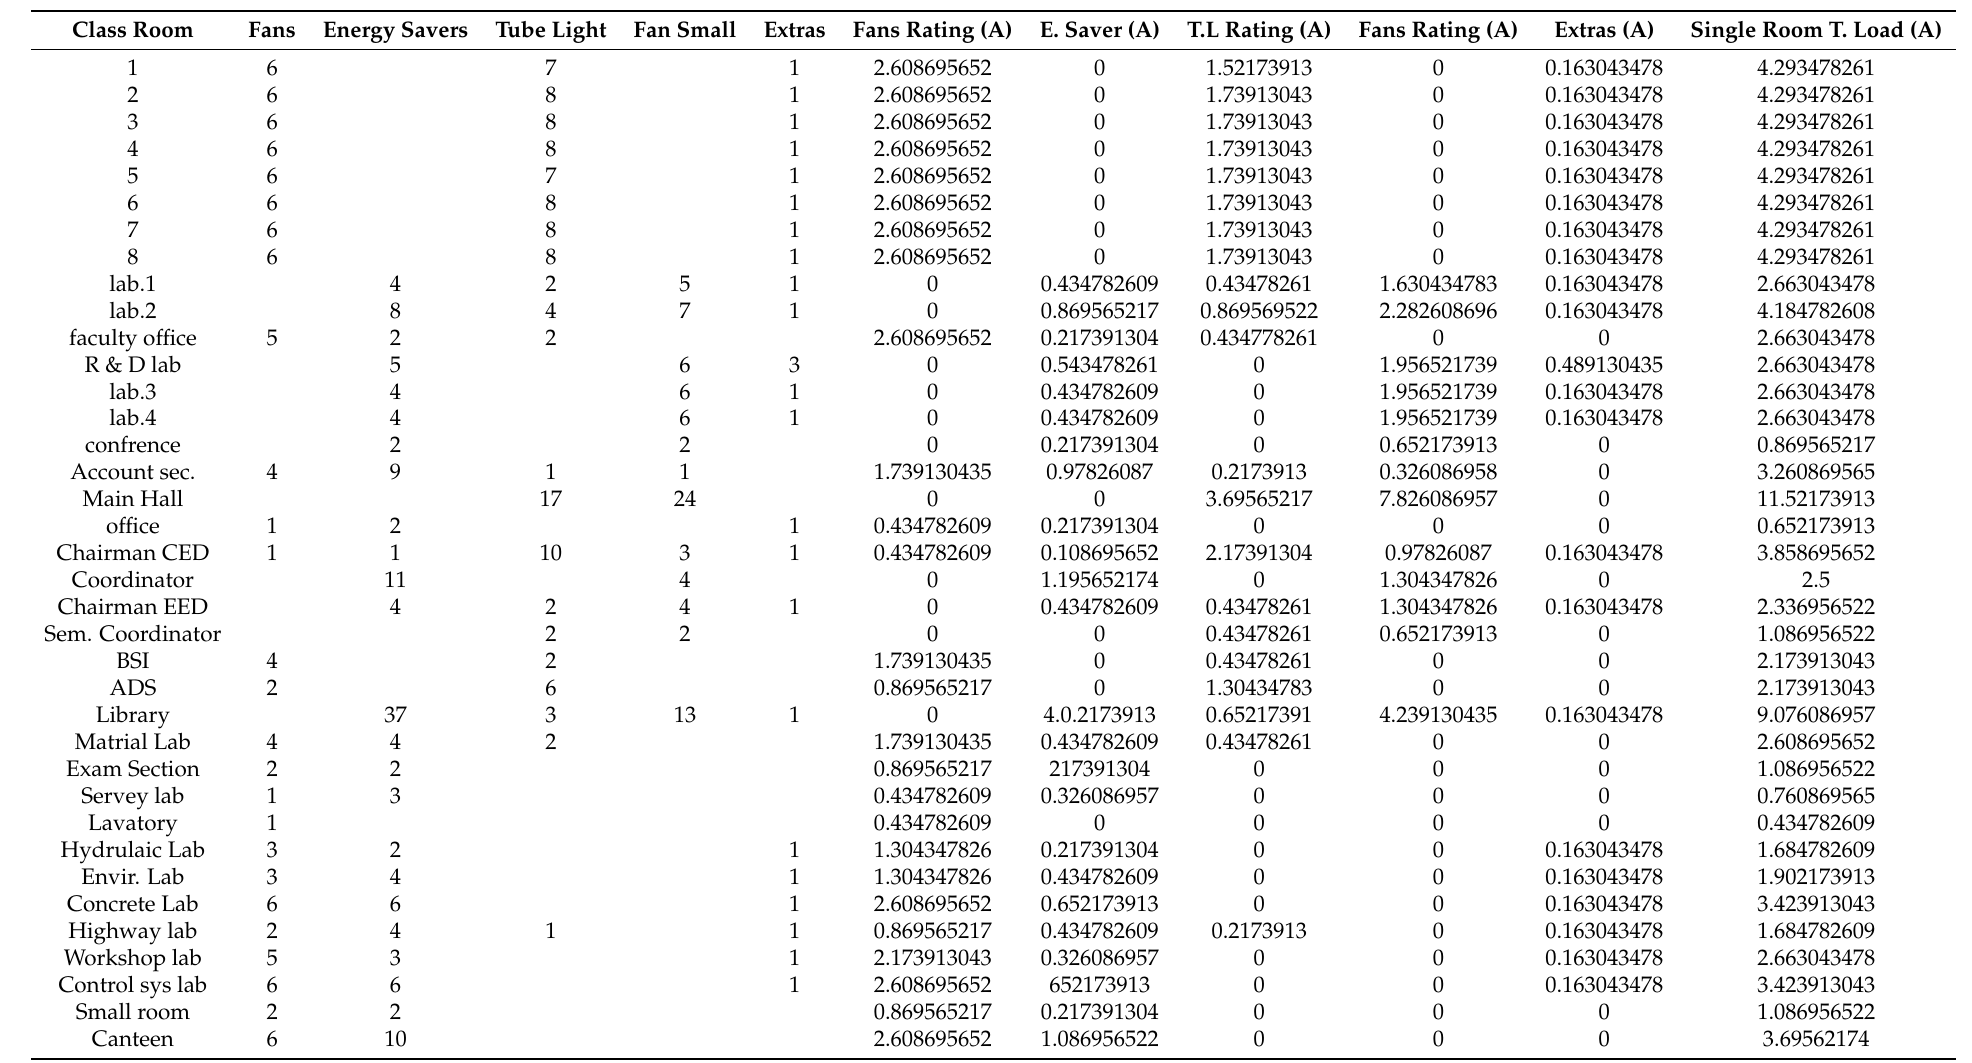
Table 1. Academic-block existing load